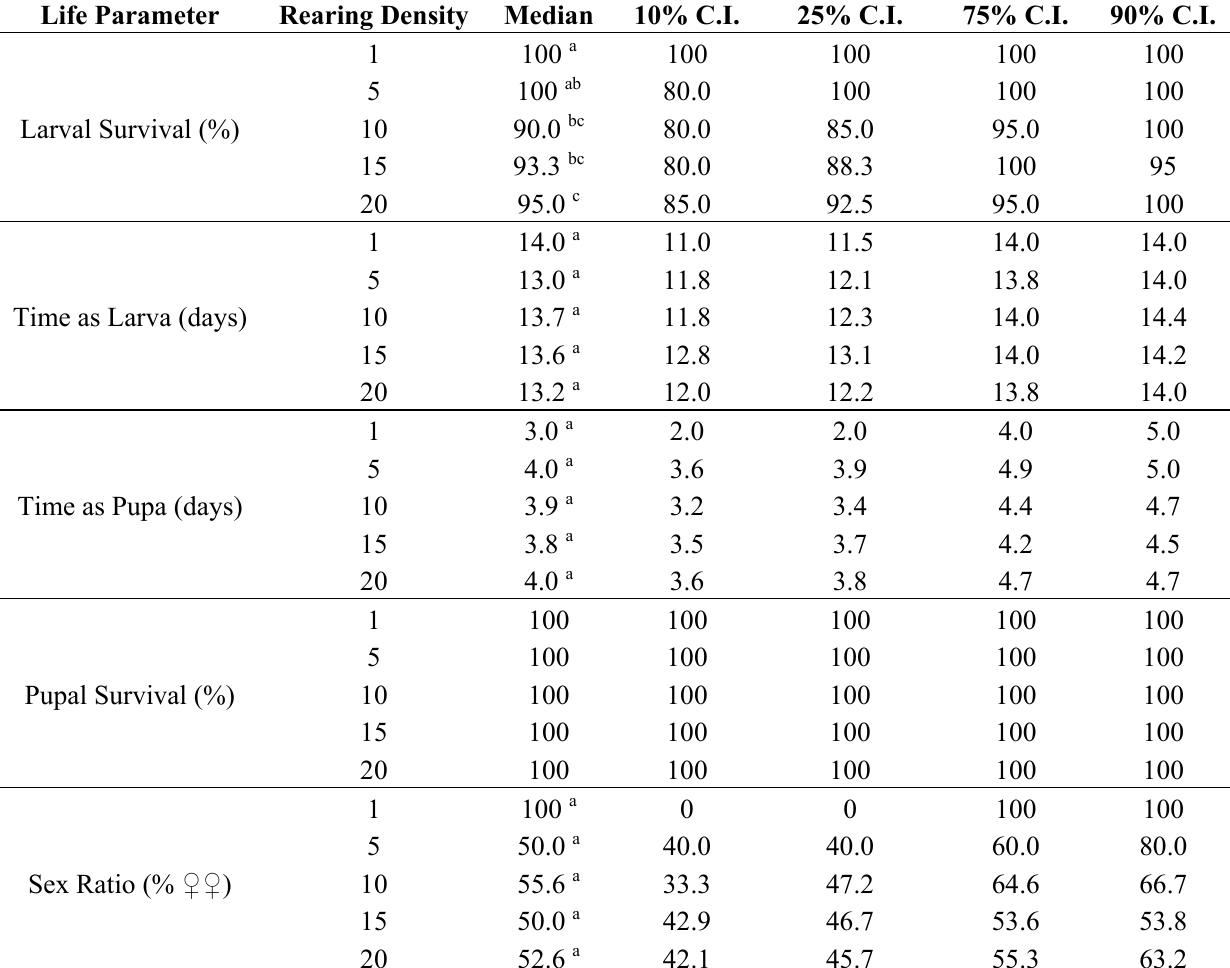
Table 1. Median values and confidence intervals for pre-imaginal survival, development time, and sex ratio of teneral adults in relation to rearing density. Median 10% C.I. 25% C.I. 75% C.I. 90%